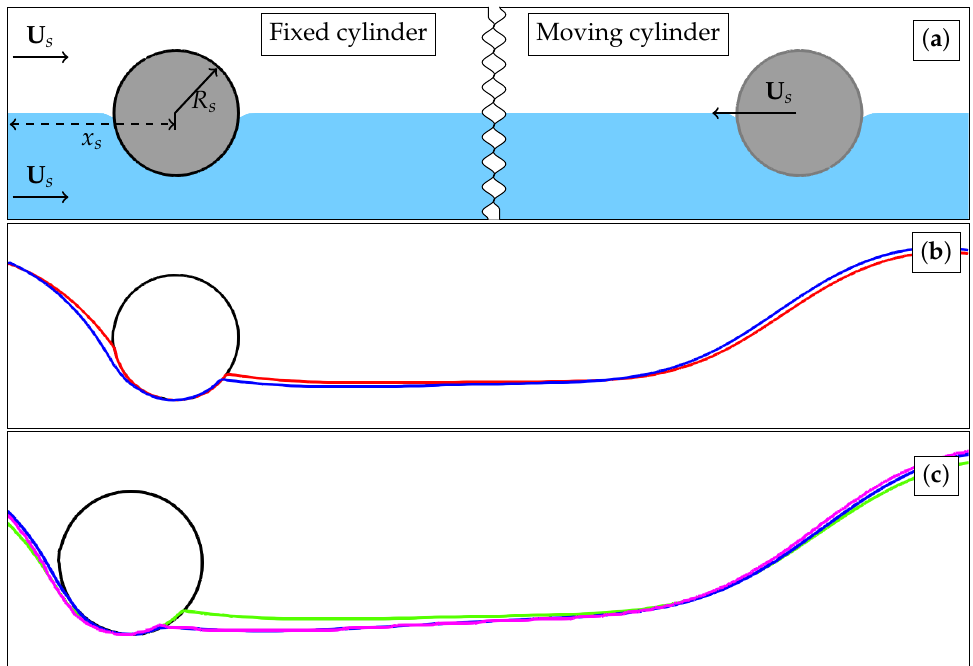
Figure 15. The test for Galilean invariance with a problem of a solid cylinder moving along the interface between two fluids. Figure ( a ) shows the initial conditions for a fixed cylinder ( left ) and moving cylinder ( right ). The arrows indicate the velocity direction in the fixed cylinder case and the cylinder direction for a moving cylinder case. Only a half of the computational domain is shown. Fluid 1 is blue, fluid 2 is white (above the interface and formally inside the solid), and solid is gray. In ( b ), the comparison of the fluid–fluid interface at t = 0.625 for a moving (blue) and fixed (red) cylinder are shown with the resolution level J max = 10. In ( c ), we test the convergence of the interface between the fluids in the case of a moving solid: J max = 9 (blue line); J max = 10 (green line); and J max = 11 (pink